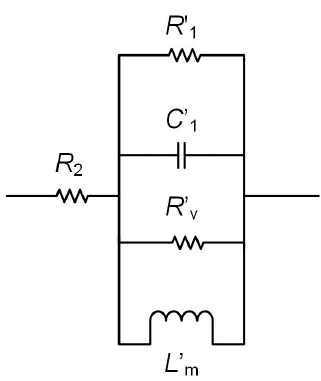
Figure A4. Parallel equivalent circuit of the inductor of Figure A3.